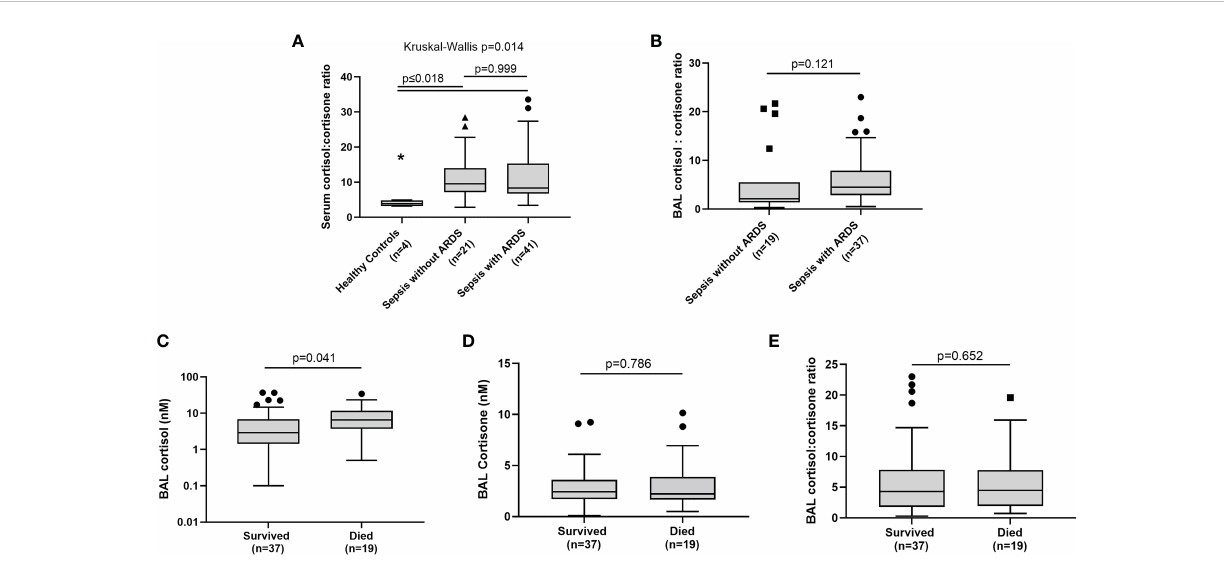
FIGURE 1 BAL and serum glucocorticoid ratios in sepsis patients with and without ARDS. Combined data from the AM-ARDS and BALTI-2 sub-study shown, n-56. Healthy volunteers n=4. Data shown as Tukey ’ s box plots. (A) Serum cortisol: cortisone ratios in healthy volunteers, sepsis patients with ARDS and sepsis patients without ARDS. (medians 3.9 v 9.59 v 8.30, Kruskal Wallis p=0.014). (B) BAL cortisol: cortisone ratios in sepsis patients with and without ARDS (2.10 v 4.50, p=0.121). (C) Association between BAL cortisol and 30 day mortality following ICU admission, across all sepsis patients (with and without ARDS) (medians 6.56 v 2.90 nM, p=0.041). (D) Association between BAL cortisone and 30 day mortality across all sepsis patients, with and without ARDS (2.43 v 2.22 nM, p=0.786). (E) Association between BAL cortisol: cortisone ratio and 30 day mortality across all sepsis patients, with and without ARDS (4.30 v 4.50, p=0.652). BAL, Broncho-alveolar lavage IT-PBS; Intra-tracheal phosphate buffered saline. IT-LPS; Intra- tracheal